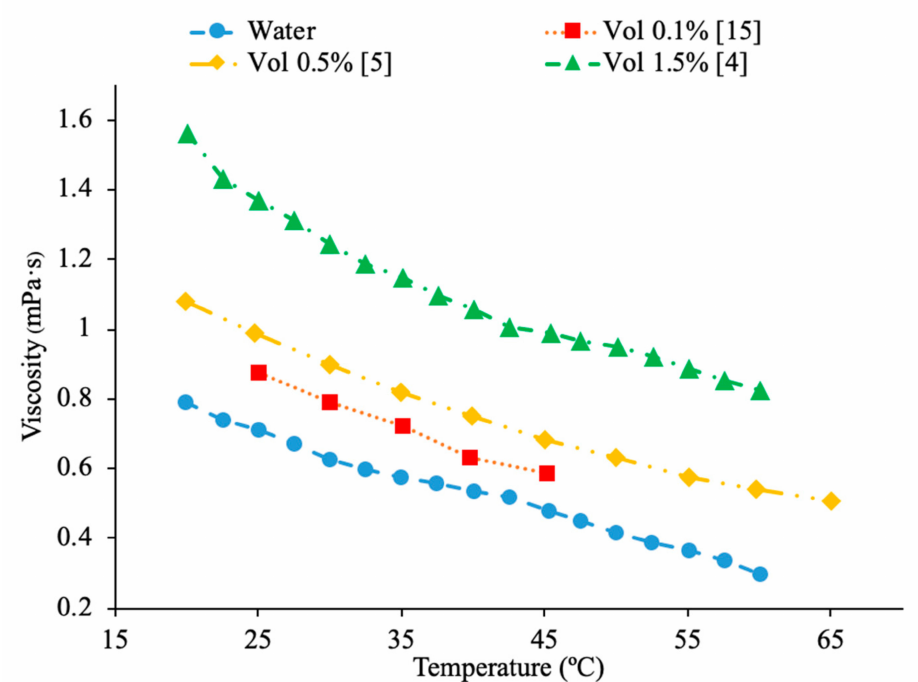
Figure 2. Viscosity of Fe 3 O 4 –water nanofluids at 0.1%, 0.5%, and 1.5% volume fractions as a function of temperature